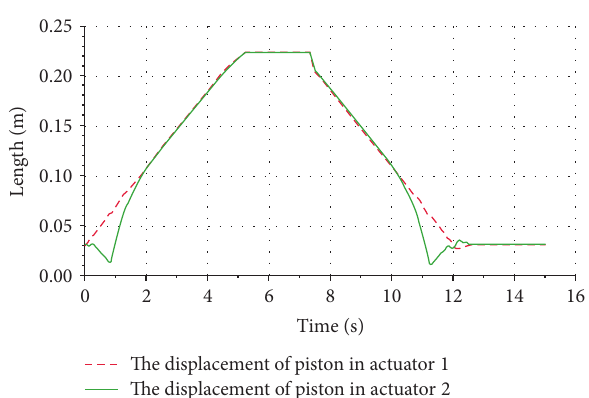
Figure 14: The piston displacement changing with time of each